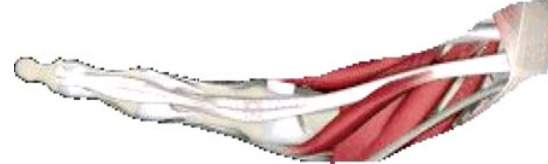
Figure 10 Muscle structure of a human index finger (Tecnoedu